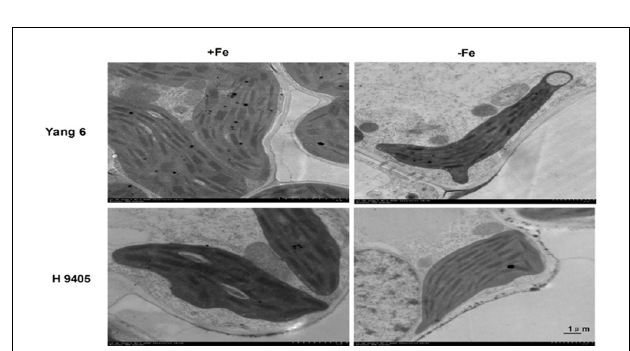
FIGURE 6 | Effects of iron deficiency on mesophyll cell ultrastructure.